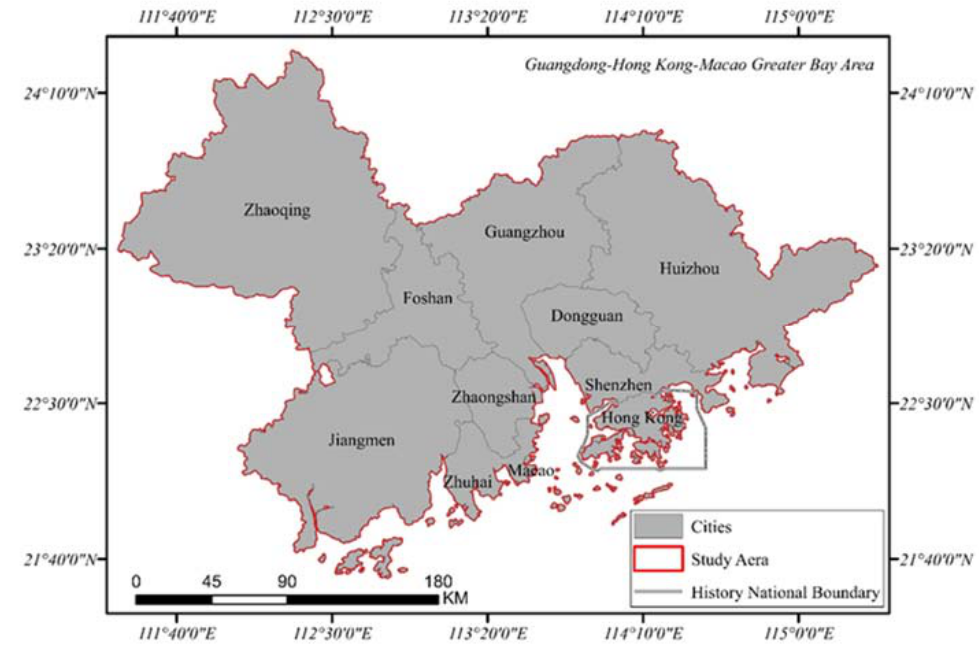
Figure 1. The Guangdong–Hong Kong–Macao Greater Bay Area (GBA).